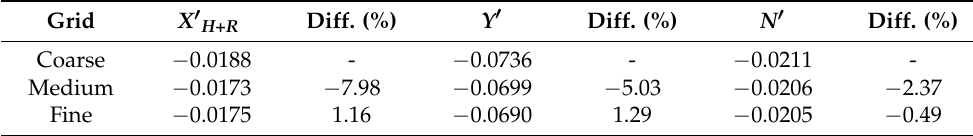
Table 6. Grid independence analysis for static drift motion by double-body flow simulation. Grid Diff. (%)